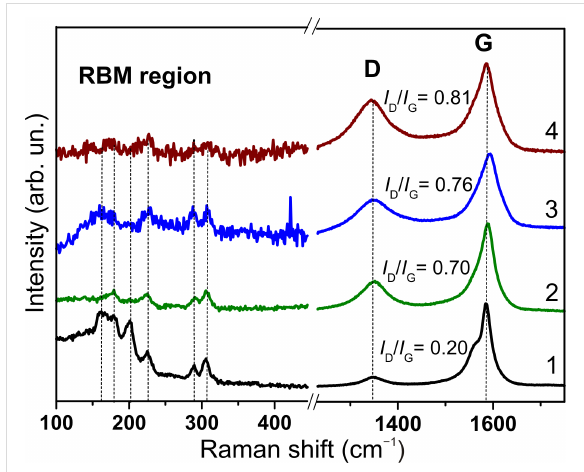
Figure 1: Raman spectra of pristine DWCNTs (1) and DWCNTs fluori- nated with CF 4 plasma (2), BrF 3 (3), and F 2 (4).